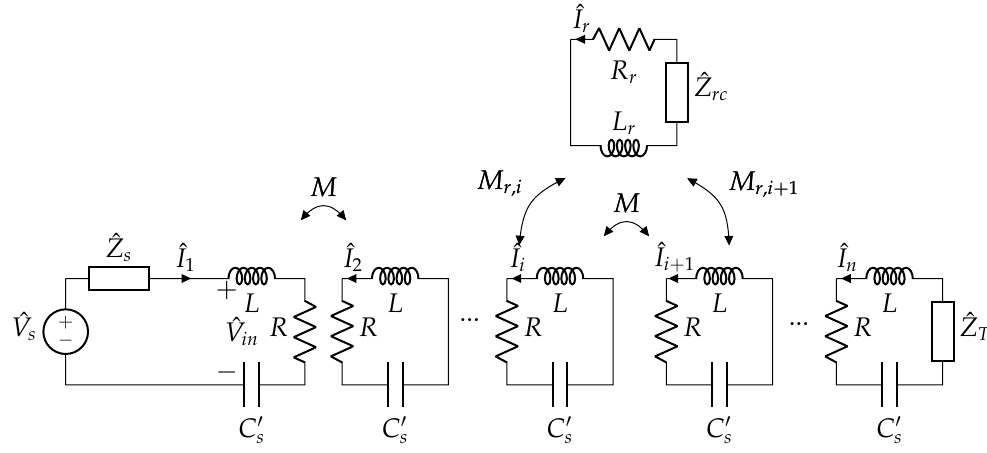
Figure 5. Equivalent circuit of the resonator array at ω 1 with a